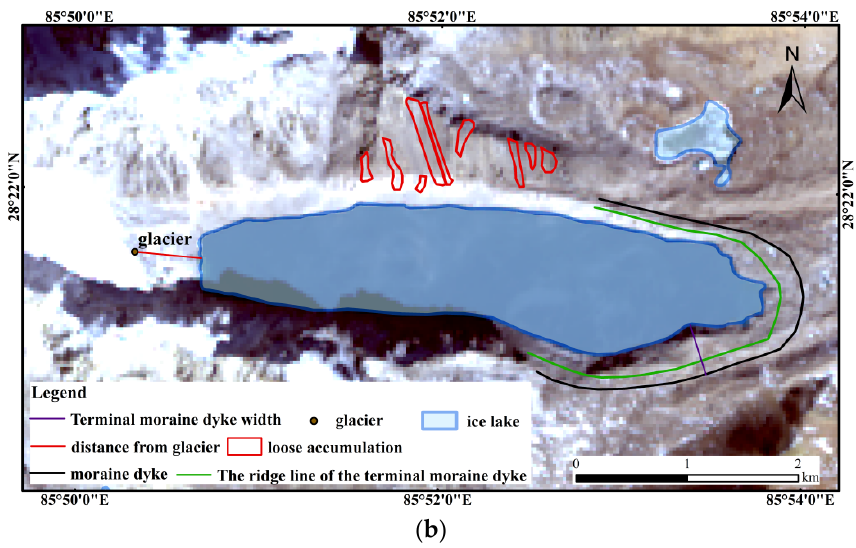
Figure 8. ( a ). Interpretation map of GangxiCo glacial lake and surroundings in 2018. ( b ). Interpreta- tion map of GangxiCo glacial lake and surroundings in 2019.